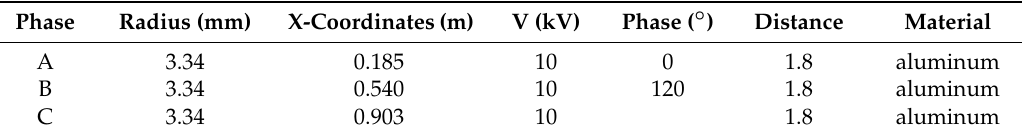
Table 3. Parameters of the simulation